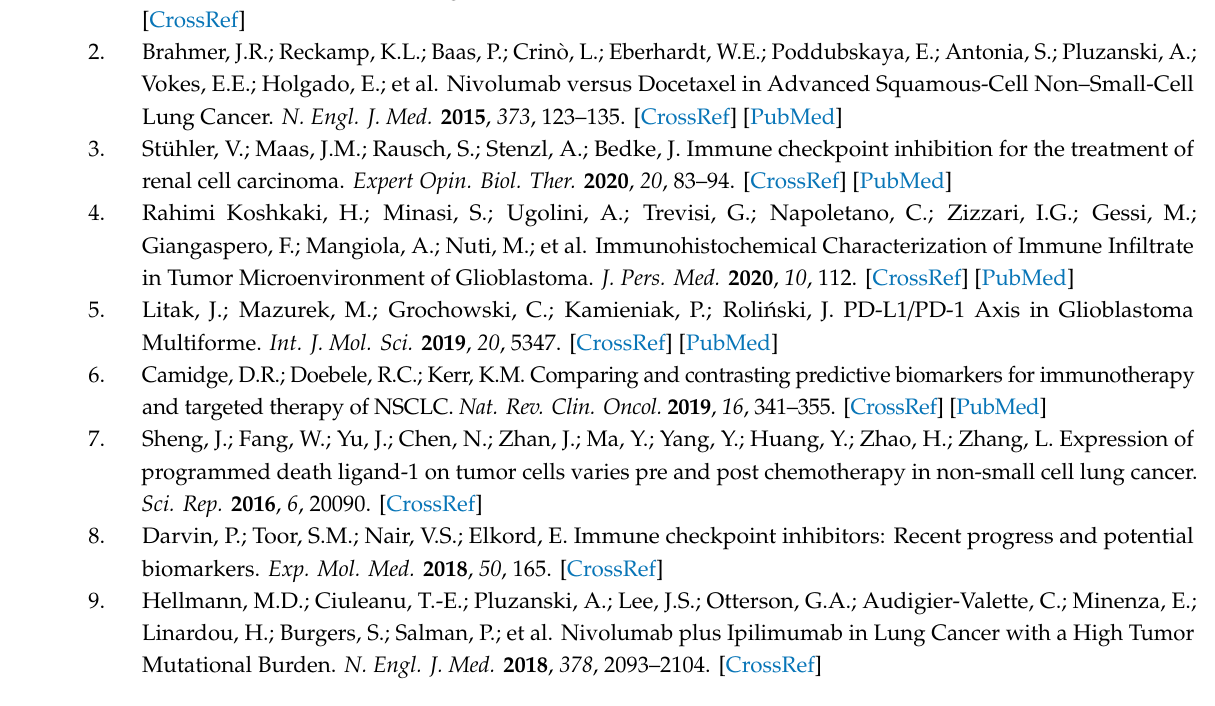
Table S1: Immune molecules analyzed in the serum of NSCLC patients at T0 and > T0 with no significant di ff erence; Table S2: Gut microbiota analysis; Table S3: Volatile and non-volatile metabolites evaluated in R and NR NSCLC patients; Table S4: volatile and non-volatile dysbiosis- and eubiosis-associated metabolites evaluated in R and NR NSCLC